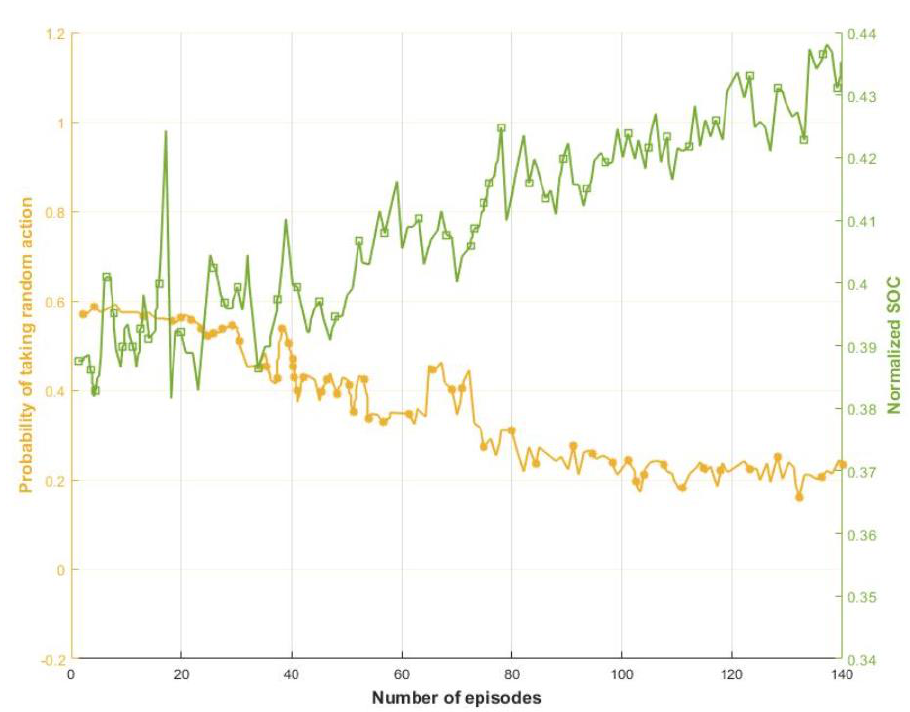
Figure 12. The level of SoC vs. probability of taking random actions for the agent during the drives.